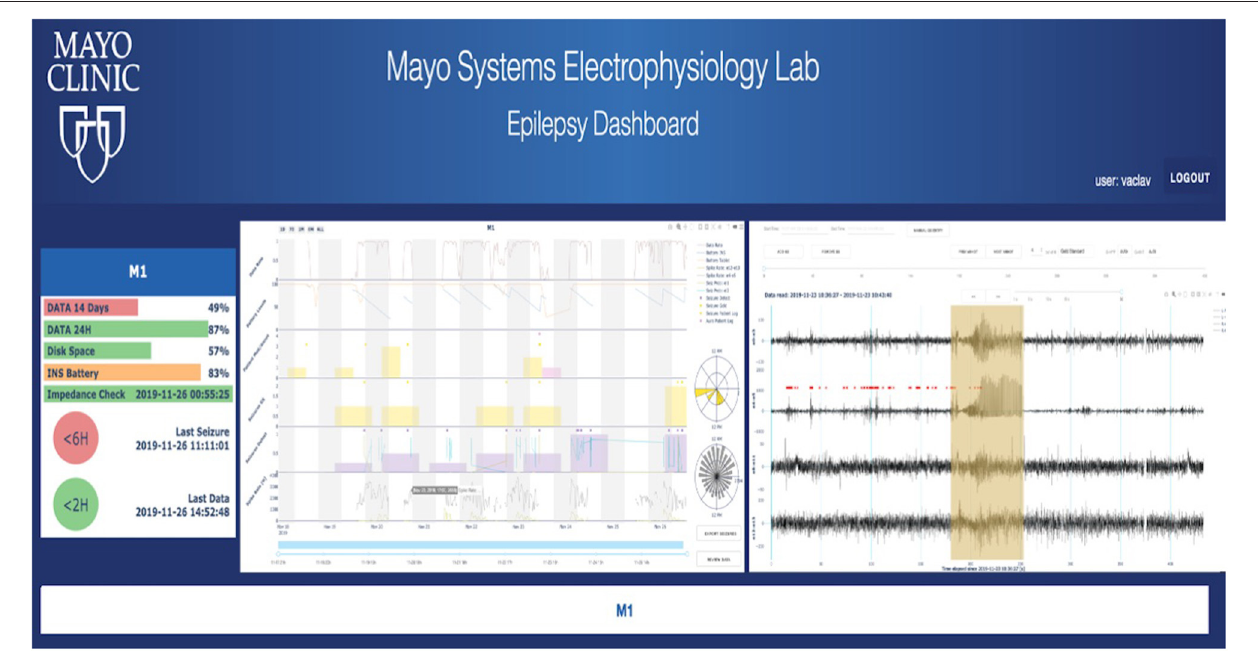
FIGURE 5 | Cloud analytics—First human subject data in the cloud longitudinal analytics system, including automated seizure detections and gold standard (expert reviewed) annotations in raw iEEG data. Other features of the iEEG are displayed, such as spike rates and their circadian timing.